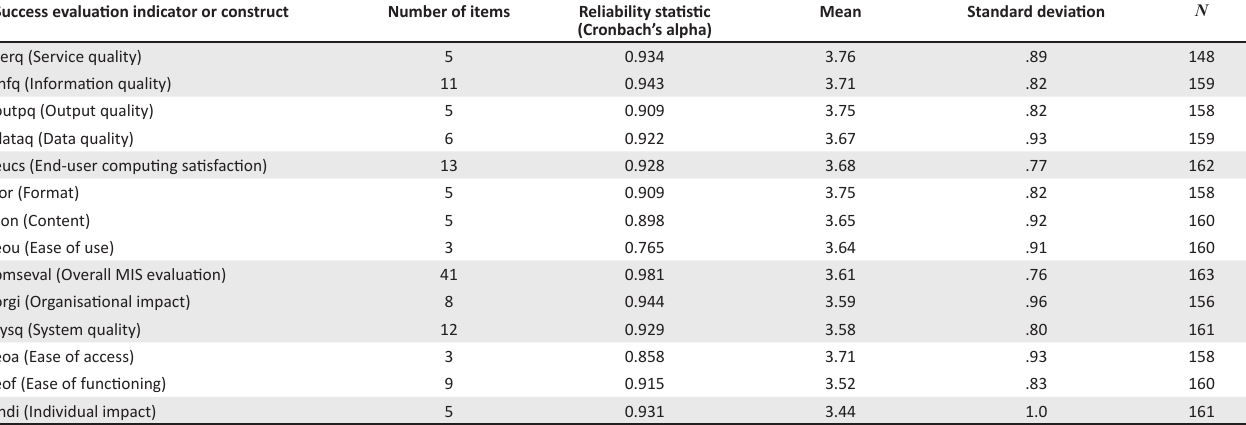
TABLE 2: Management information systems evaluation construct measurements and reliability statistic. Success evaluation indicator or